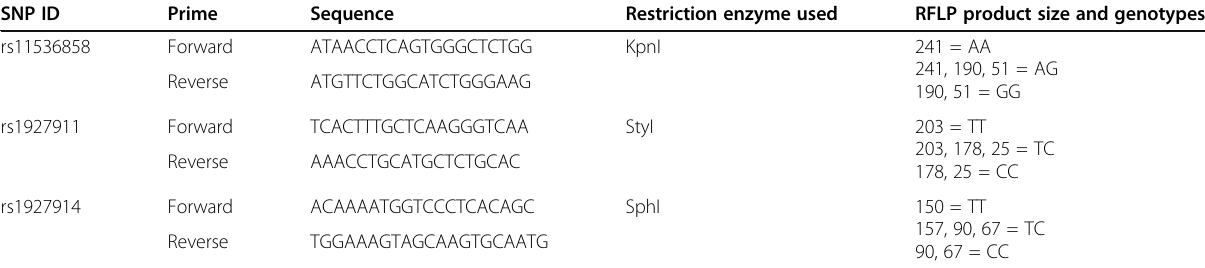
Table 1 Primers for PCR-RFLP of the TLR4, restriction enzymes used, and RFLP products size and genotypes SNP ID